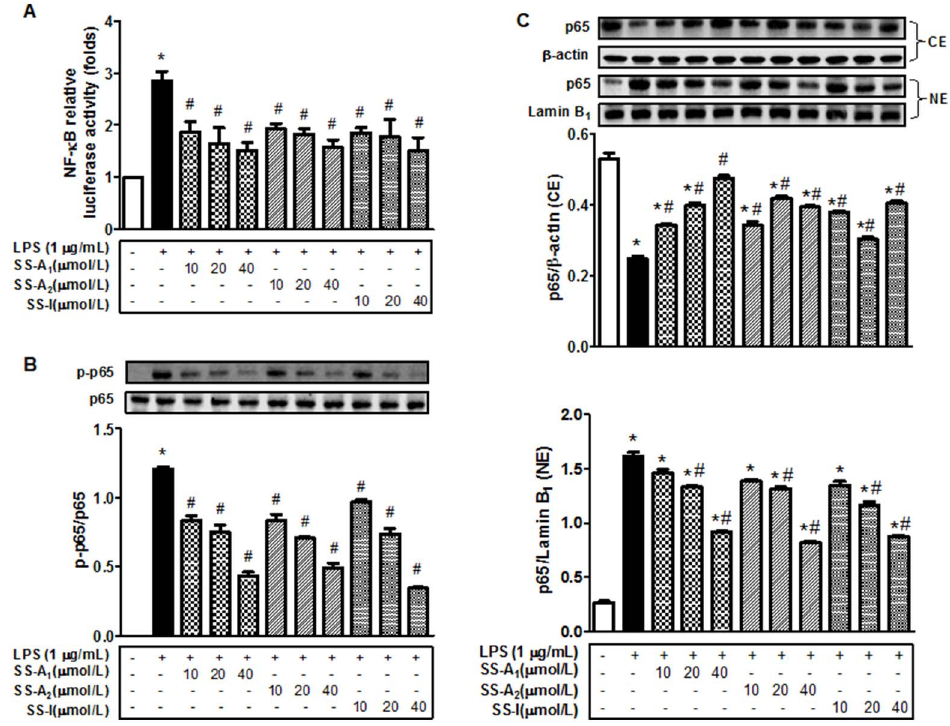
Figure 3. Soyasaponins inhibit the LPS-induced activation of NF-kB in macrophages. ( A ) The pNF-kB-Luc reporter plasmid was introduced into macrophages via transient transfection and then stimulated for 16 h with 1 m g/mL LPS in the absence or presence of increased concentrations of soyasaponins (10–40 m mol/L). The level of luciferase activity was quantified determined and presented as fold of the negative control, which was set as 1. ( B ) Macrophages were pre-treated with 10, 20, or 40 m mol/L of soyasaponins (A1, A2 and I) for 2 h, and then stimulated with LPS (1 m g/mL) for 15 min as noted. Levels of targets proteins in the whole cell lysates were evaluated with immunoblotting. ( C ) Macrophages were pre-treated with 10, 20, or 40 m mol/L of soyasaponins (A 1 , A 2 and I) for 2 h, and then stimulated with LPS (1 m g/mL) for 1 h as noted. The level of p65 in the nuclear and cytosolic extracts was determined by using immunoblotting. Lamin B 1 was used as the nuclear protein marker and b -actin as the cytosolic protein marker. Results are presented as means 6 SD of 3 independent experiments. *: P , 0.05 vs. control. # : P , 0.5 vs. LPS alone.